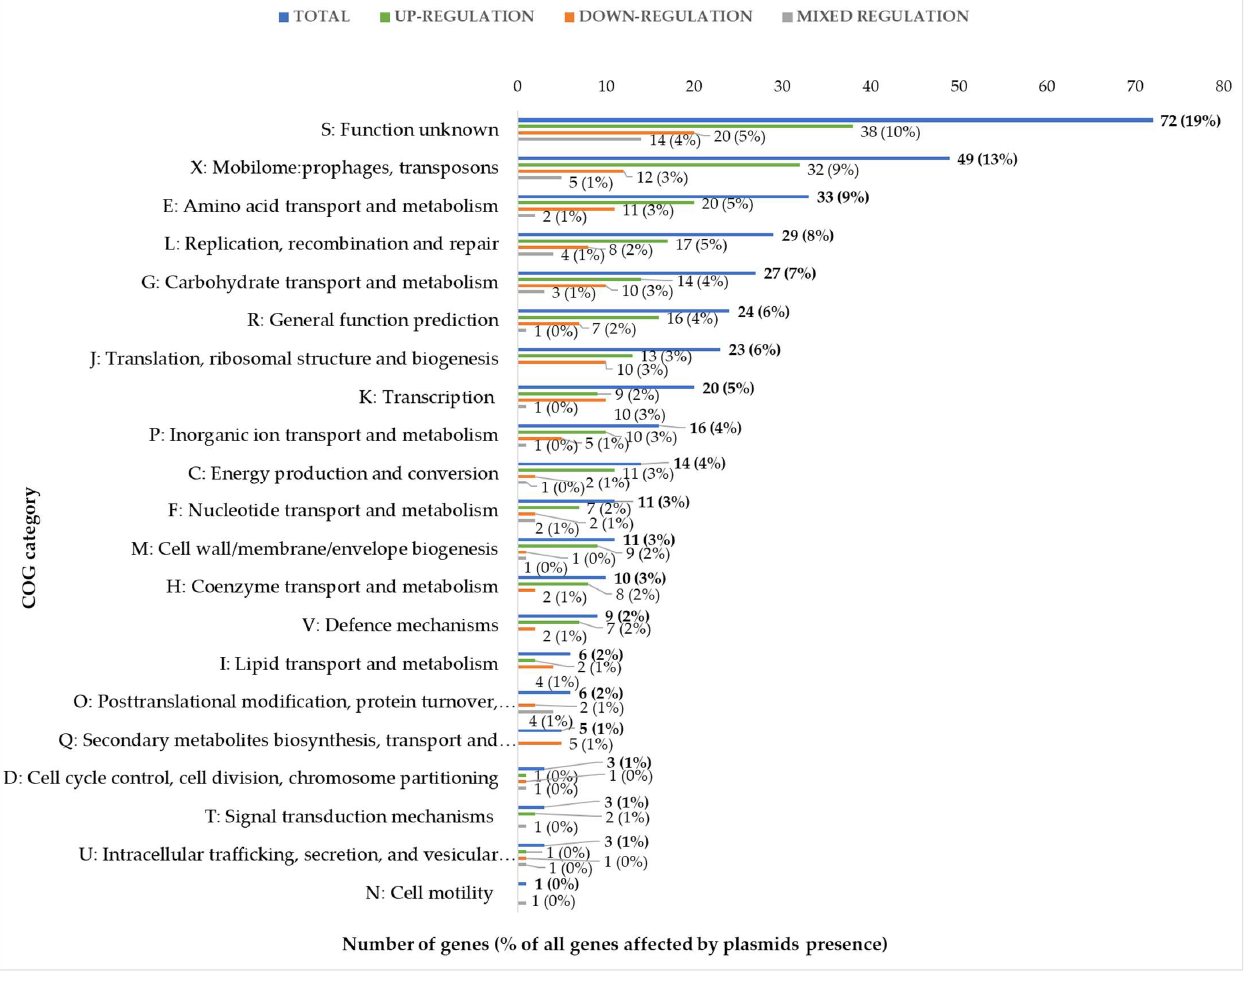
Figure 3. Numbers and percentage (in brackets) of unique differentially expressed chromosomal genes in L. lactis IL594 during growth on three carbon sources in four growth phases with identified COG categories. The percentages presented in brackets refer to the proportion of genes from the analysed COG category to the total number of genes with altered expression profiles.